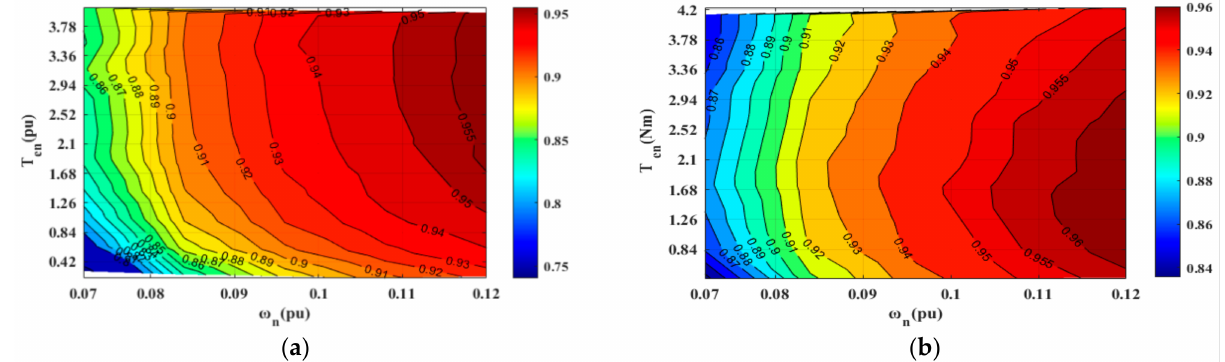
Figure 12. The inverter efficiency MAP. ( a ) traditional algorithm. ( b ) fixed SVPWM modulation index algorithm.